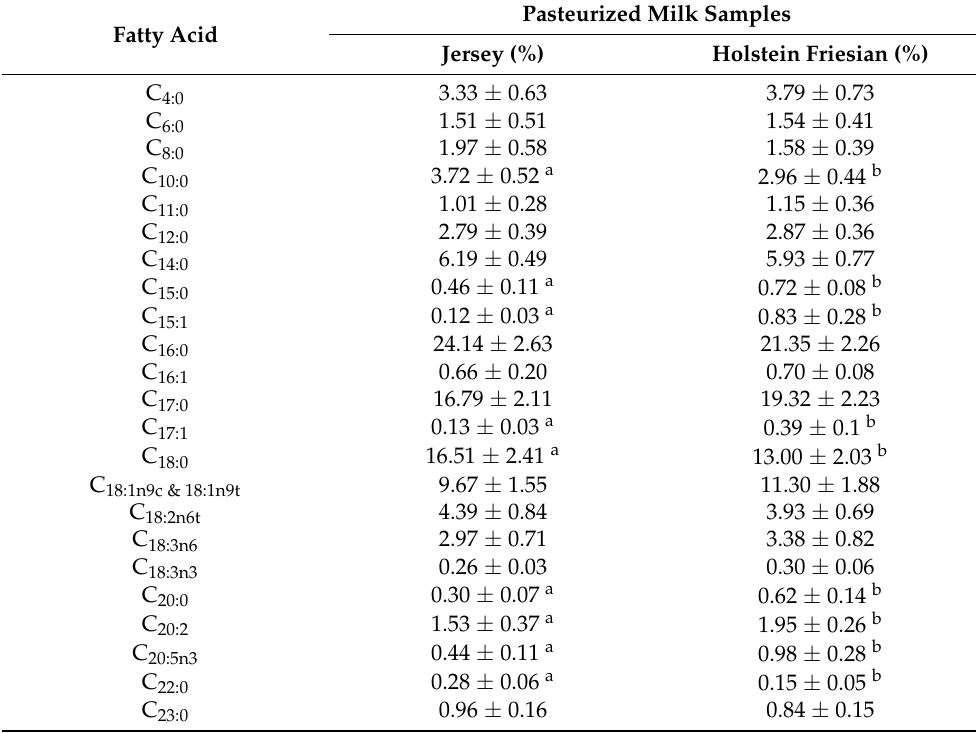
Table 2. Fatty acid composition of pasteurized milk from Jersey and Holstein Friesian